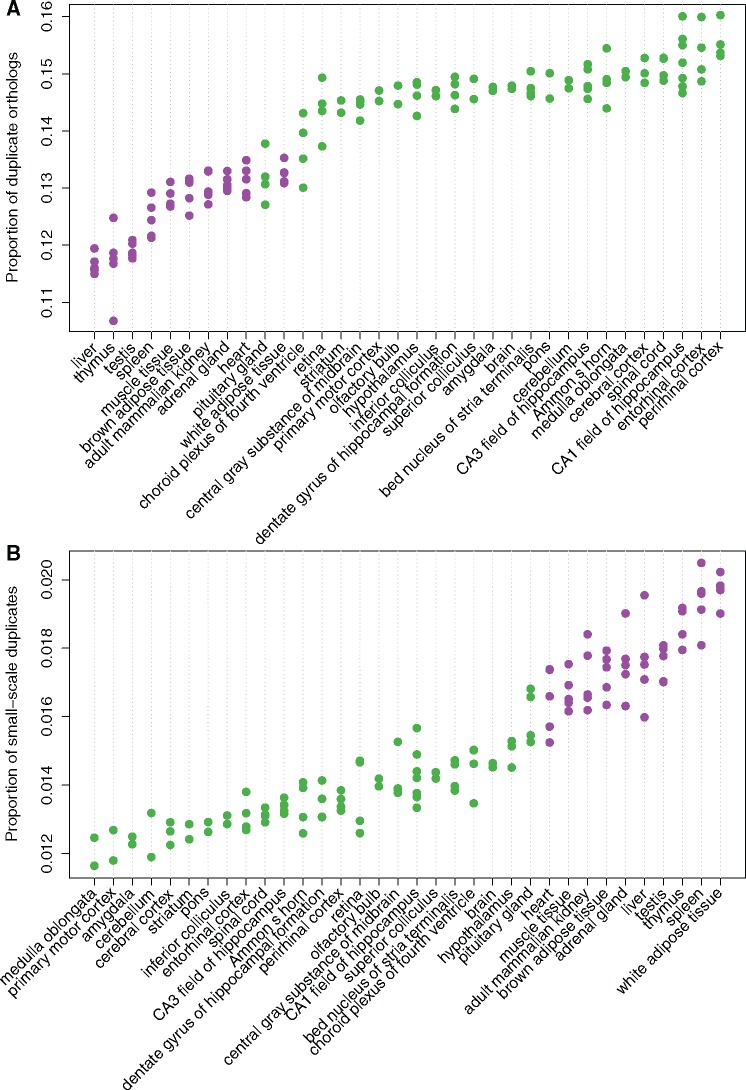
Proportion of mouse orthologs of zebrafish 3R ohnologs among genes expressed in the different tissues sampled in the GSE3594 microarray experiment. The reference gene set was composed only of mouse orthologs of zebrafish 3R ohnologs and singletons. Tissues are ranked based on the average proportion of orthologs of ohnologs expressed. Each dot represents a sample (biological replicate). Green color represents nervous-system tissues and purple represents nonnervous-system tissues.